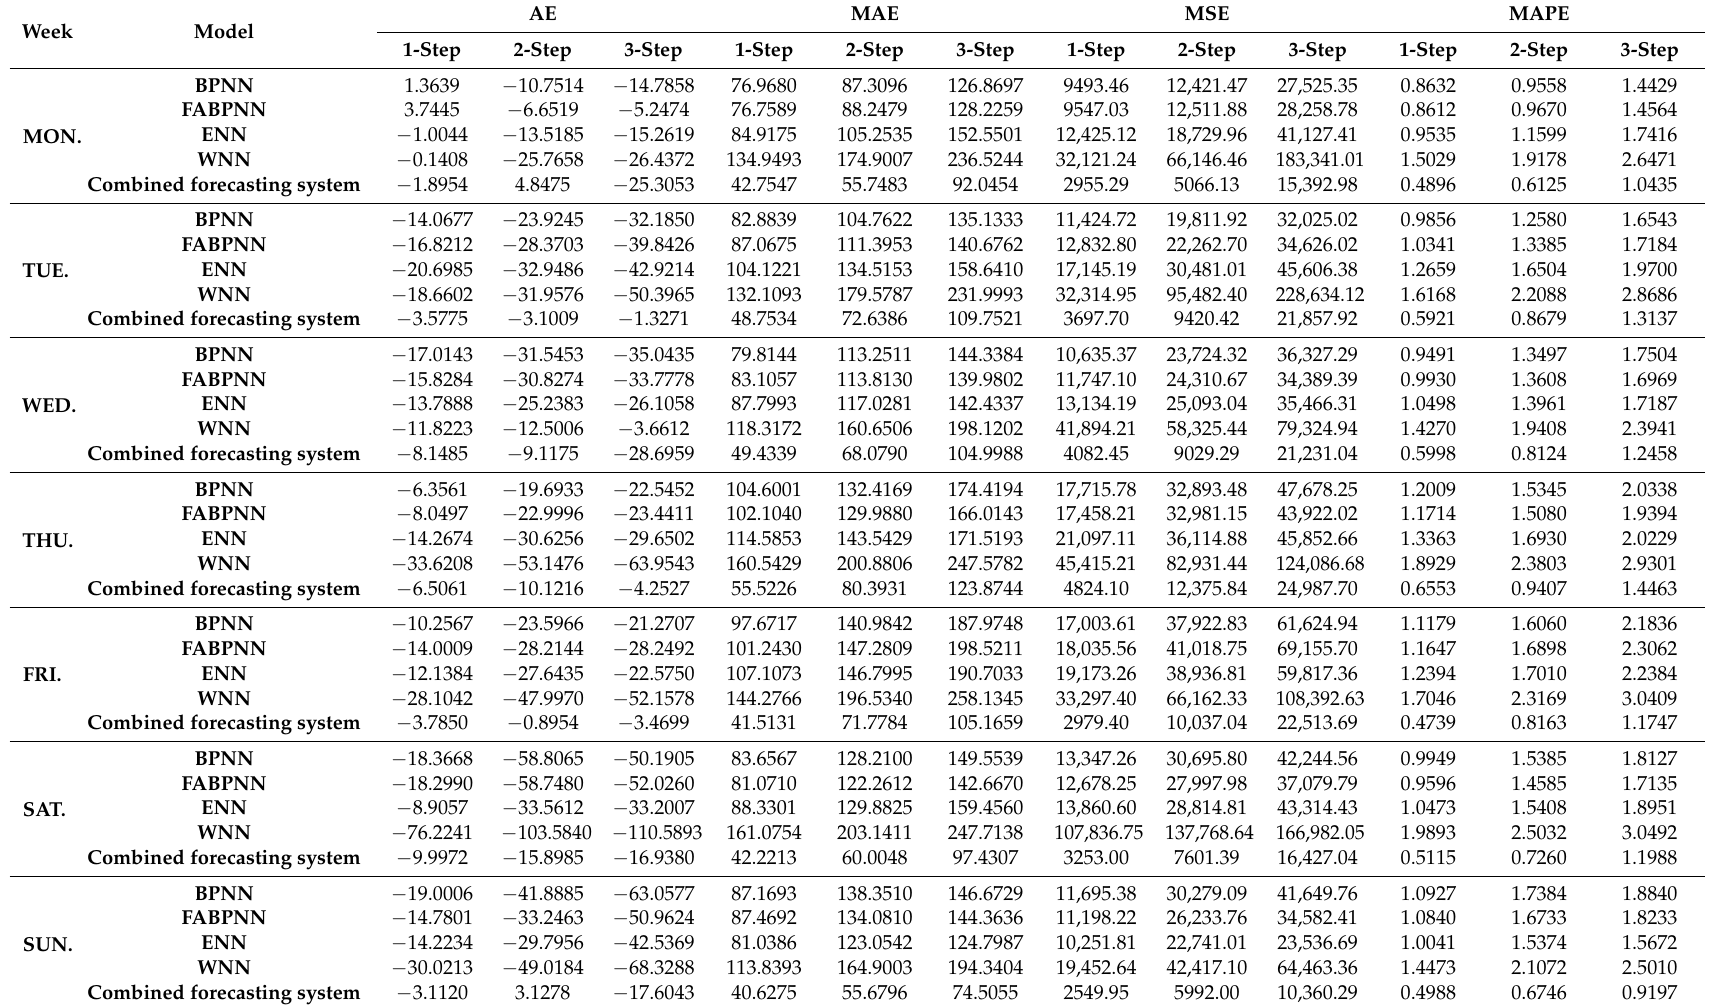
Table 4. Forecasting results obtained using February data from New South